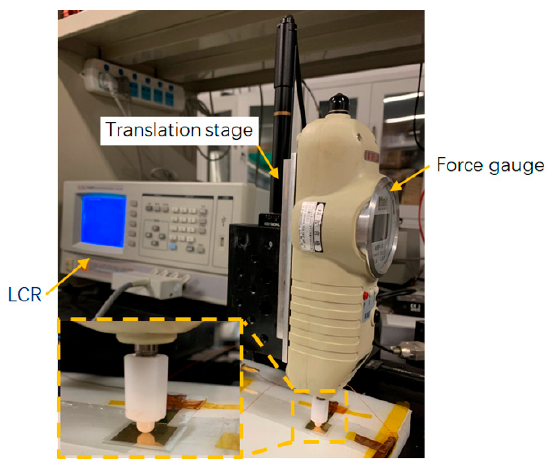
Figure 2. Photograph of the full experimental setup.